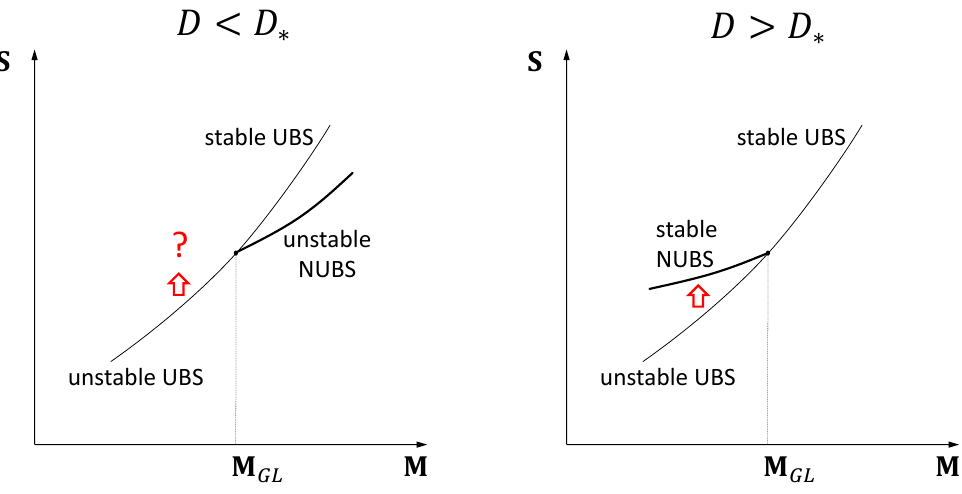
Figure 2 . Eq. (3.11), and more accurately (3.12), shows that for D < D (cid:3) there are no weakly non-uniform black strings with mass M < M GL = 1 in the range of unstable uniform black strings, so the latter cannot evolve smoothly into any of the former (the transition is then of (cid:12)rst order into a phase further away, possibly other NUBS or BH). For D > D (cid:3) the mass correction is reversed, and there do exist NUBS with M < M GL that unstable UBS can smoothly evolve into. The calculation of the entropy in (3.16) shows that in D > D (cid:3) this transition is consistent with the entropy law. Moreover, the analysis of section 4 explicitly shows that weakly NUBS are dynamically linearly stable when D > D (cid:3) , and unstable when D < D (cid:3)